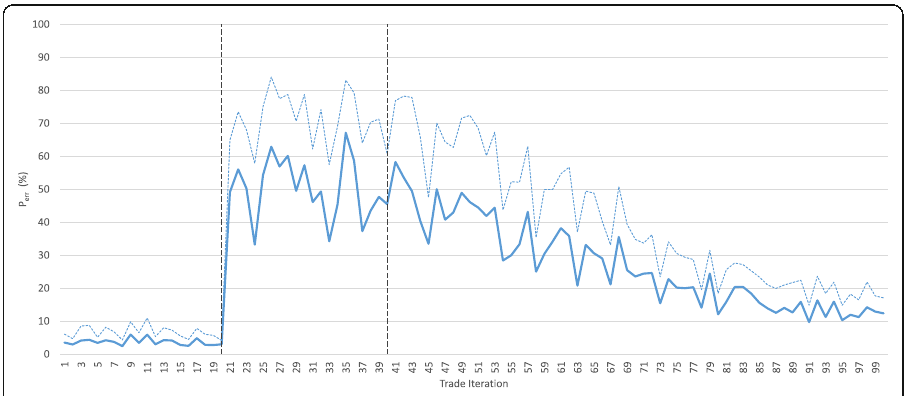
Fig. 11 Prediction error (P err ) using a random trade time for each iteration. Area to the left of the dashed lines with the default configuration, followed by a change in decision criteria that is gradually adapted to in the final 60 iterations to the right of the dashed lines. Dotted line shows + 1 standard